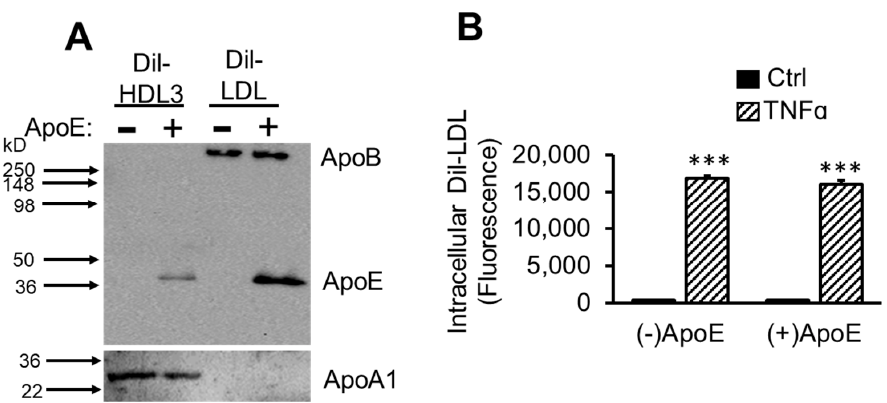
Figure 6. ApoE is not required for TNF α -induced Dil-LDL accumulation. ( A ) Dil-HDL3 or Dil-LDL was depleted of apoE ( − ), or apoE was retained (+) as described under Section 2. The presence of apoB and apoE were determined by immunoblotting 0.5 and 1 µ g/mL Dil-HDL3 and Dil-LDL, respectively. ( B ) pHAECs were treated ± 100 ng/mL TNF α in serum medium for 24 h. Following 2 h incubation in serum free medium, in the continued presence of TNF α , the cells were incubated with 2.5 µ g/mL Dil-LDL without ( − ) or with apoE (+) for 3 h. n = 3. ***, p < 0.001, relative to Ctrl.